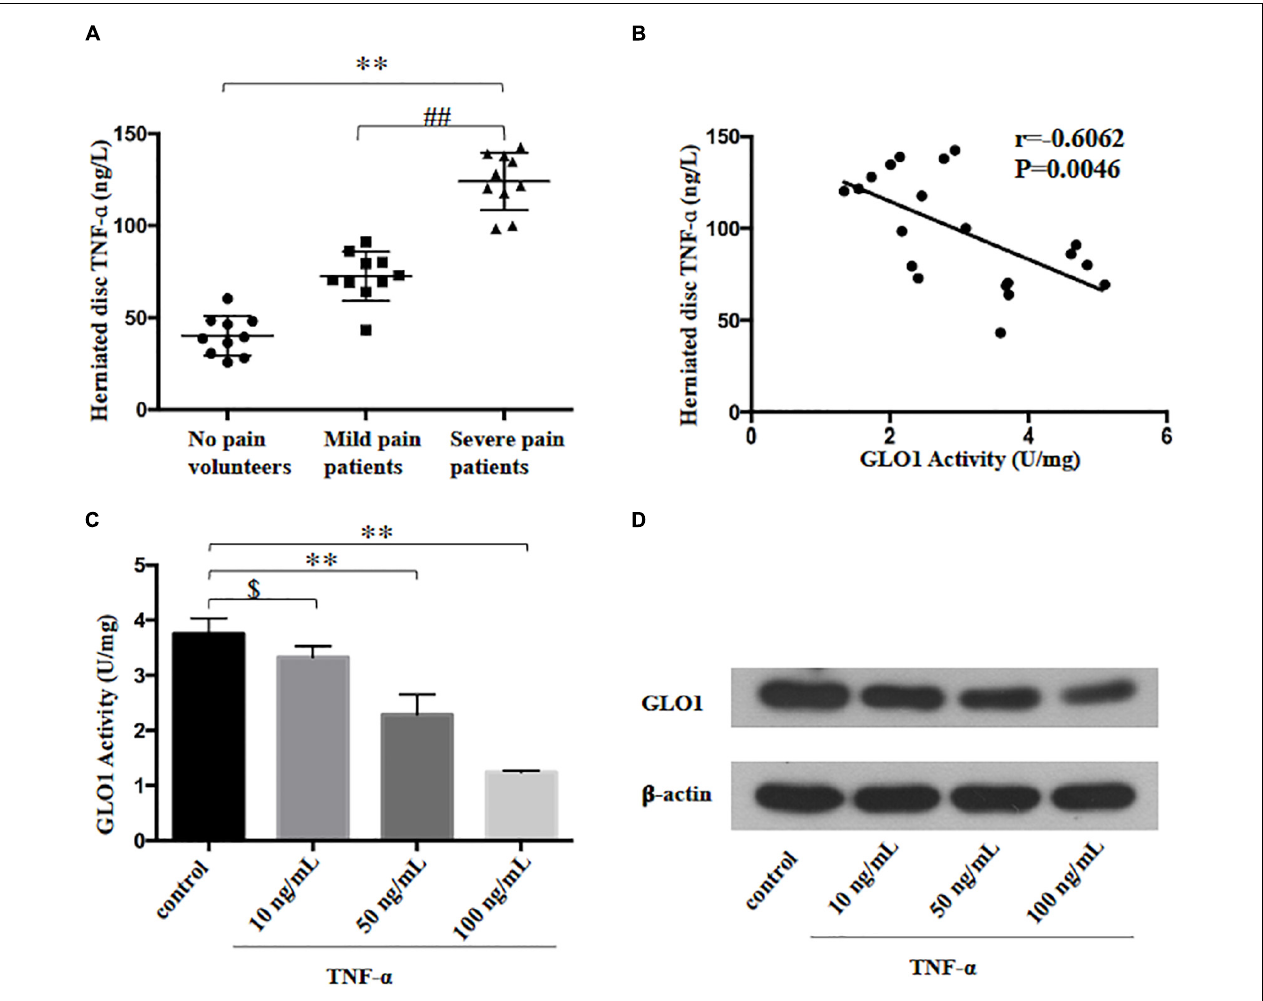
FIGURE 3 | Tumor necrosis factor-alpha (TNF- A )-reduced GLO1 activity and expression in herniated disc and cultured nucleus pulposus cell. (A) TNF- A levels were evaluated in herniated disc of the patients or volunteers (One-way ANOVA: F = 100.443, p < 0.001; post hoc Bonferroni: ∗∗ p < 0.001, volunteer with no pain vs. patients with severe pain. ## p < 0.001, patients with mild pain vs. patients with severe pain, n = 10). (B) The analysis of linear correlation between TNF- A levels and GLO1 activity in herniated disc of patients. (C,D) Both GLO1 activity and expression of NP cells were decreased by different doses of TNF- A (One-way ANOVA: F = 58.312, p < 0.001; post hoc Bonferroni: control vs. 10 ng/ml TNF- A : $ p = 0.446; control vs. 50 ng/ml TNF- A : ∗∗ p = 0.001; control vs. 100 ng/ml TNF- A : ∗∗ p <